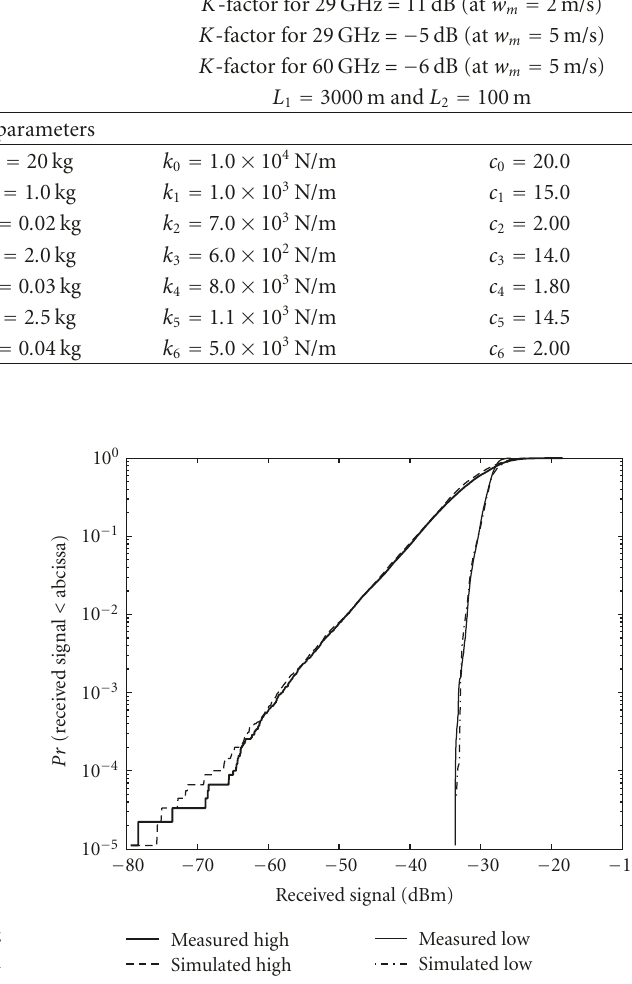
Figure 11: CDFs of measured (dry leaved deciduous trees (Site 1)) and simulated (using the new model) signals at 29GHz during low ( w m = 2m/s) and high ( w m = 5m/s) wind speed conditions. All simulation parameters are given in Table